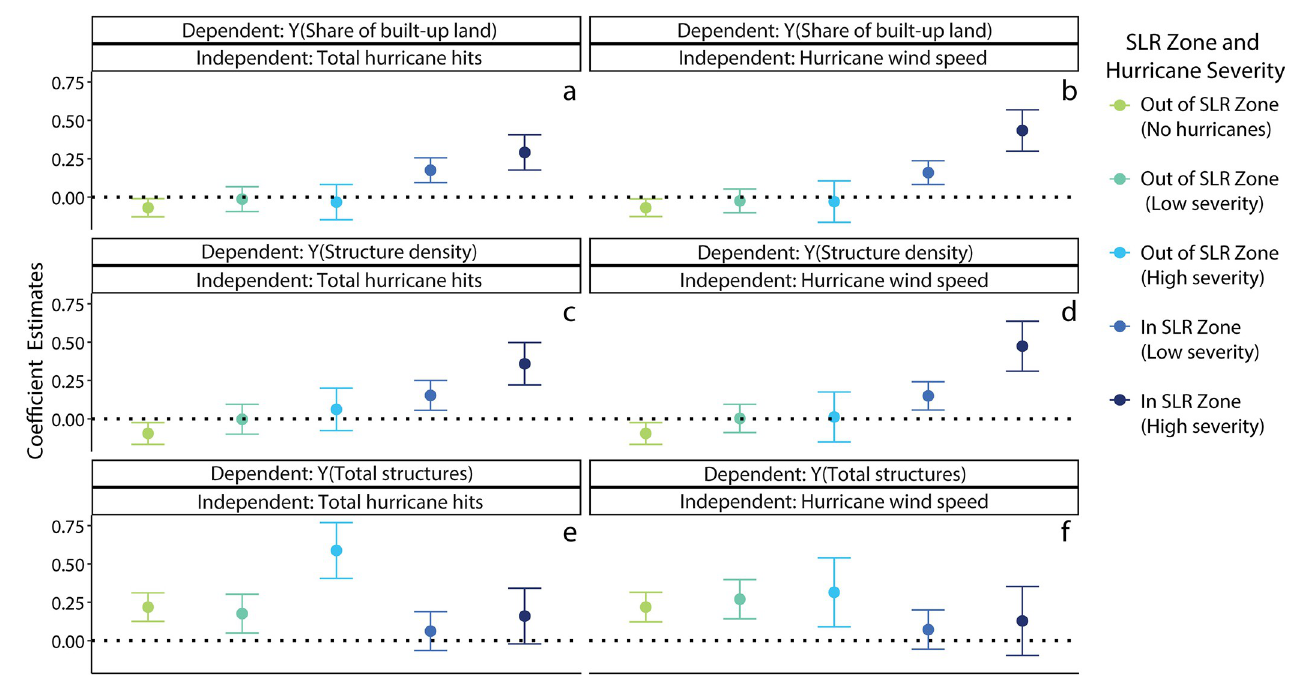
Fig 6. Results from six regressions (a-e) using 3 dependent variables (share of built-up land, structure density, total structures) x 2 independent variables (wind speed, total historical hits) across five units of analysis (MSA zones within and out of the SLR and no, low, or high impact from hurricanes). The dependent variables were measured in 2015 and the models include a census division fixed effect. The coefficient estimates (y-axis) from the regressions are all relative to a SLR zone with no storms in the database (the zero line in the graphs). In models that use wind speed, MSAs classified as low severity were hit by less severe storms that have average max wind speeds < 100 mph; high severity MSAs were hit by severe storms, those that have average max wind speeds > 100 mph (b, d, f). In the regression models using hurricane hits (a, c, e); severe levels of storm hits are defined as places hit by 5 or more storms since 1900, less severe levels are those with 1–4 storm hits since 1900. Higher coefficient estimates illustrate higher rates of structure density or total structures relative to MSAs not affected by hurricanes.